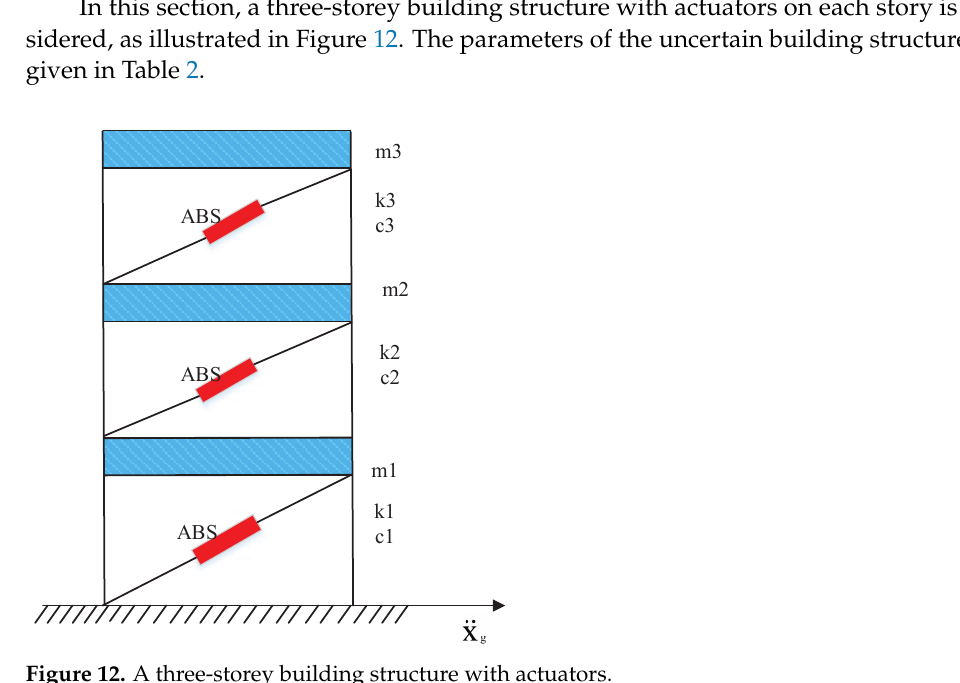
Figure 12. A three-storey building structure with actuators.